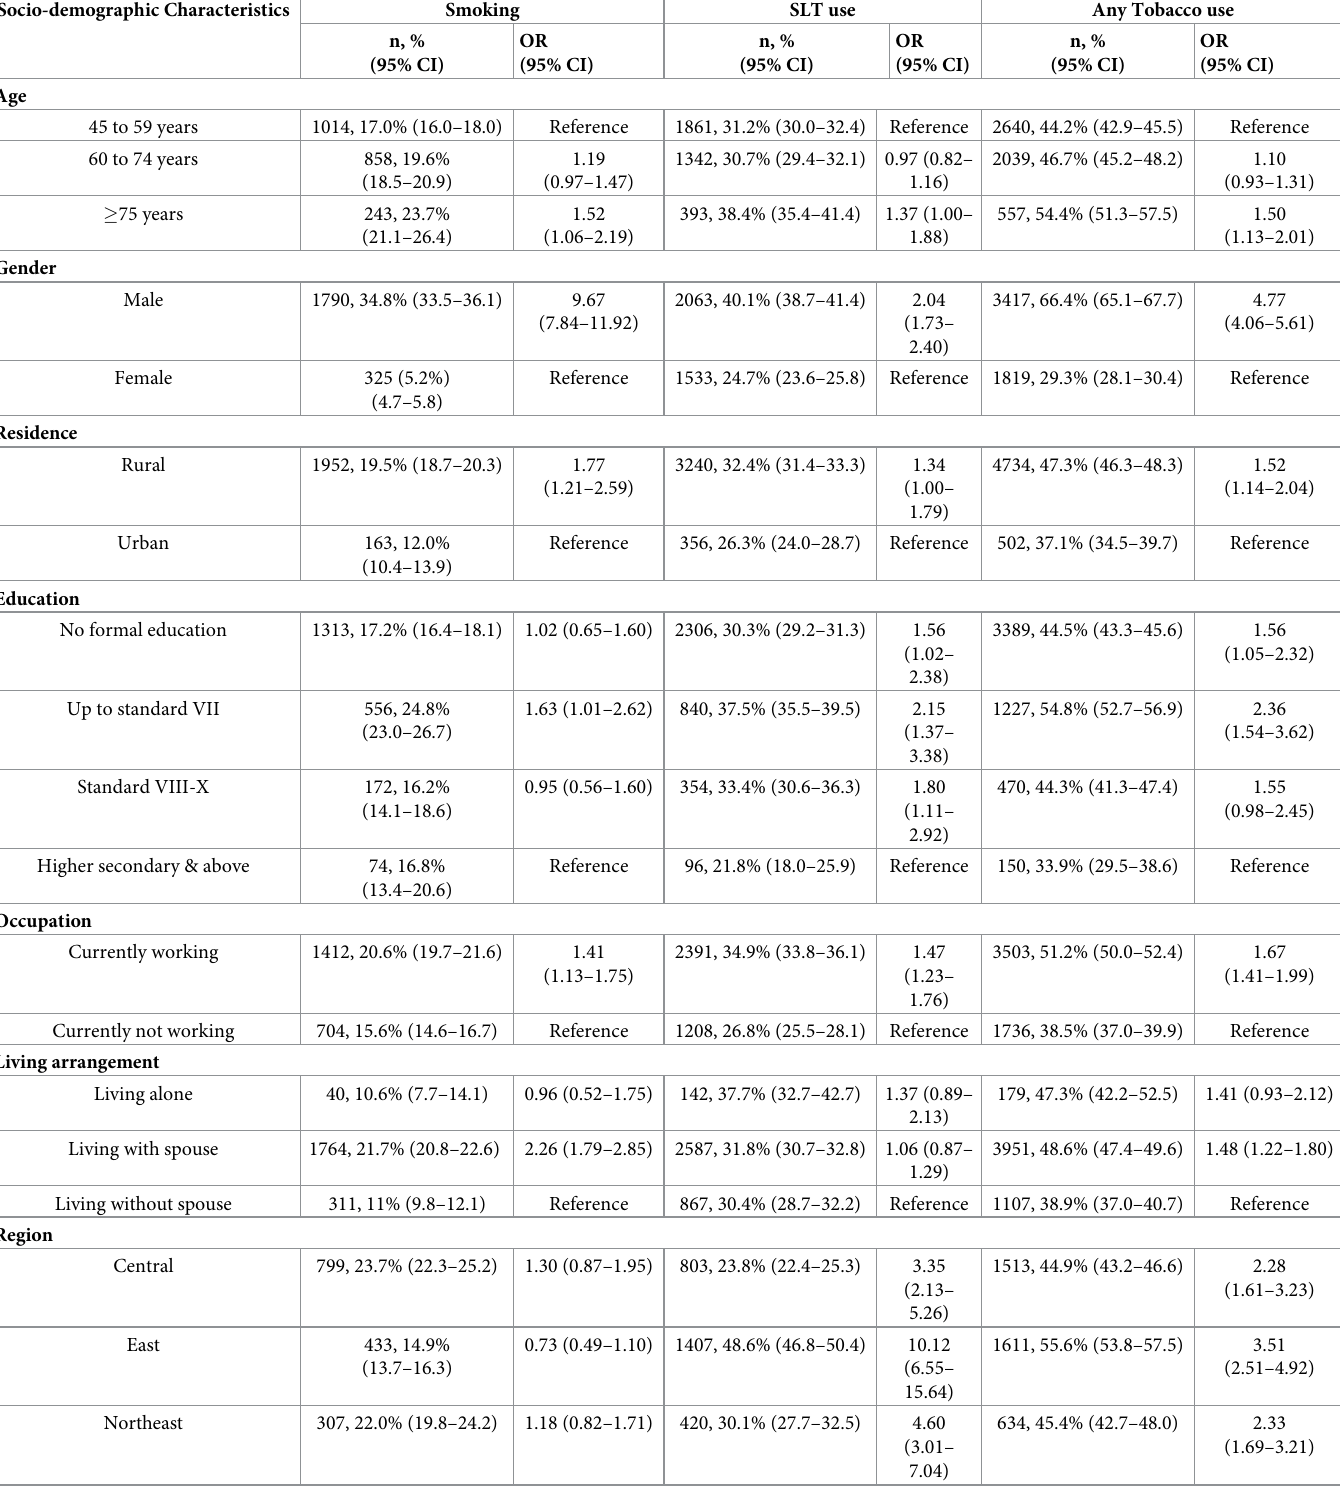
Table 2. Prevalence of various forms of tobacco and its univariate association with socio-demographic characteristics. Socio-demographic